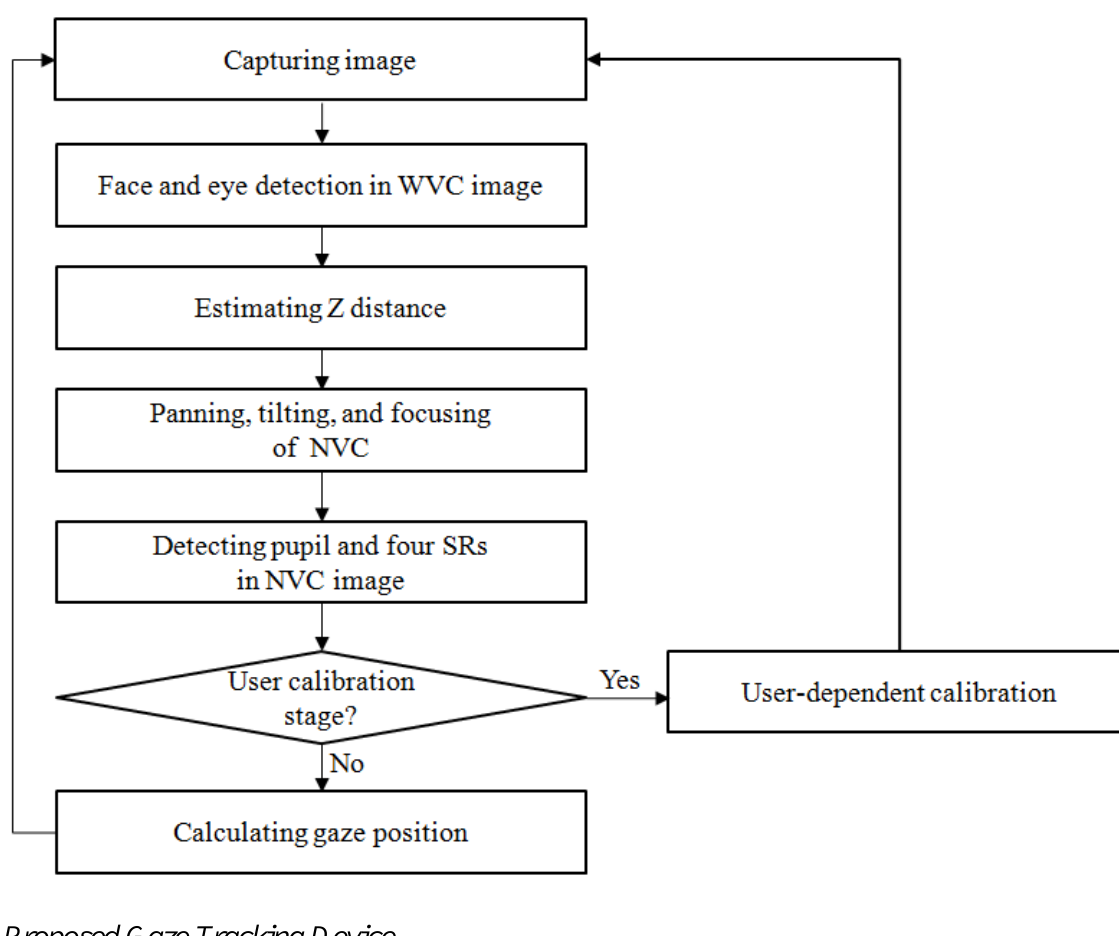
Figure 1. Flow chart of the proposed gaze tracking